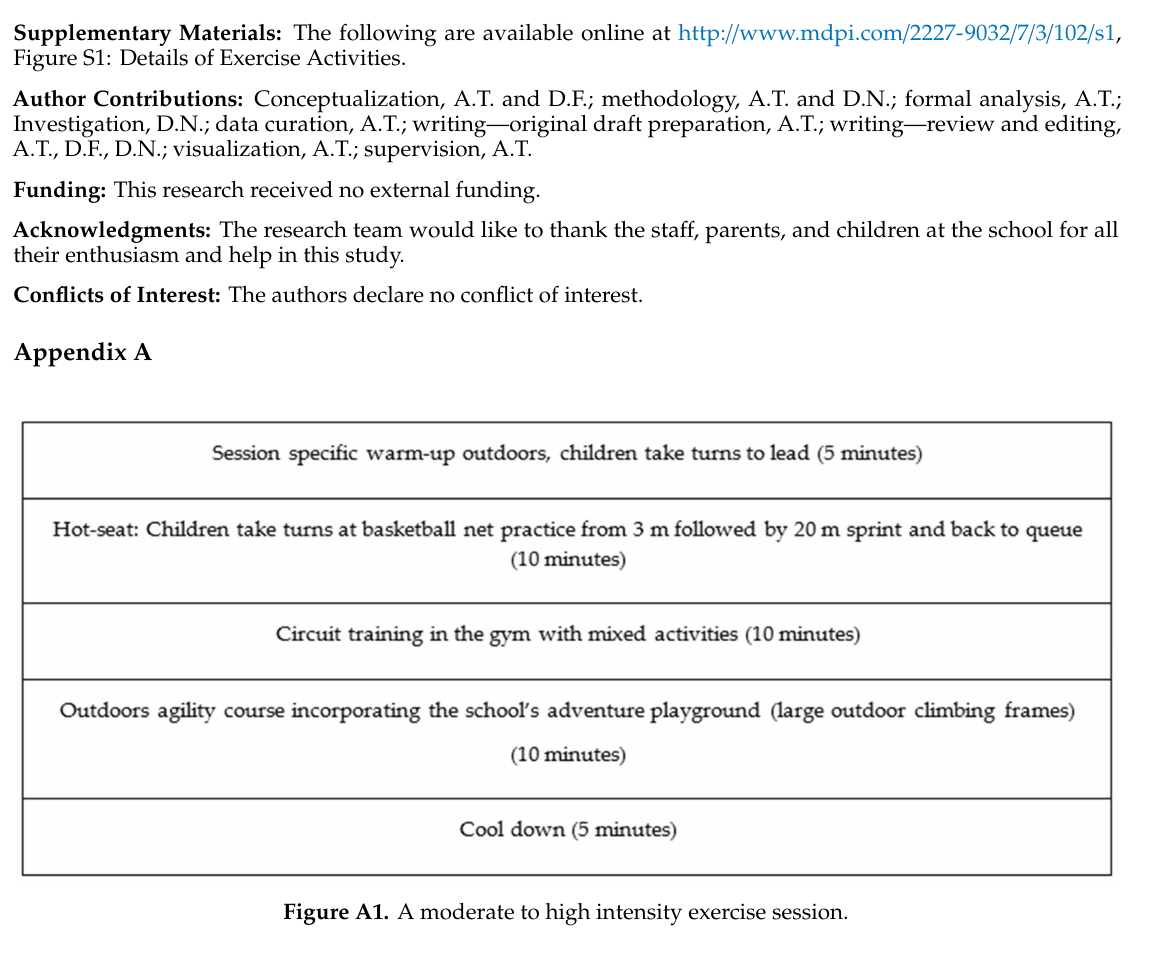
Figure S1: Details of Exercise Activities.